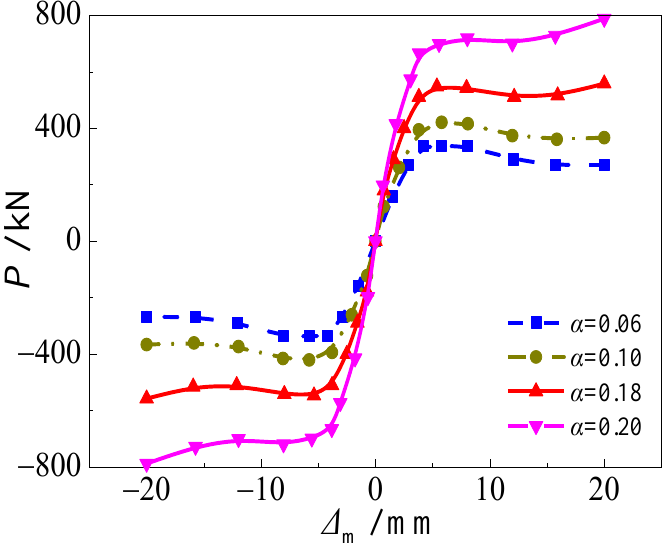
Figure 18. Effect of steel ratio on skeleton curve.